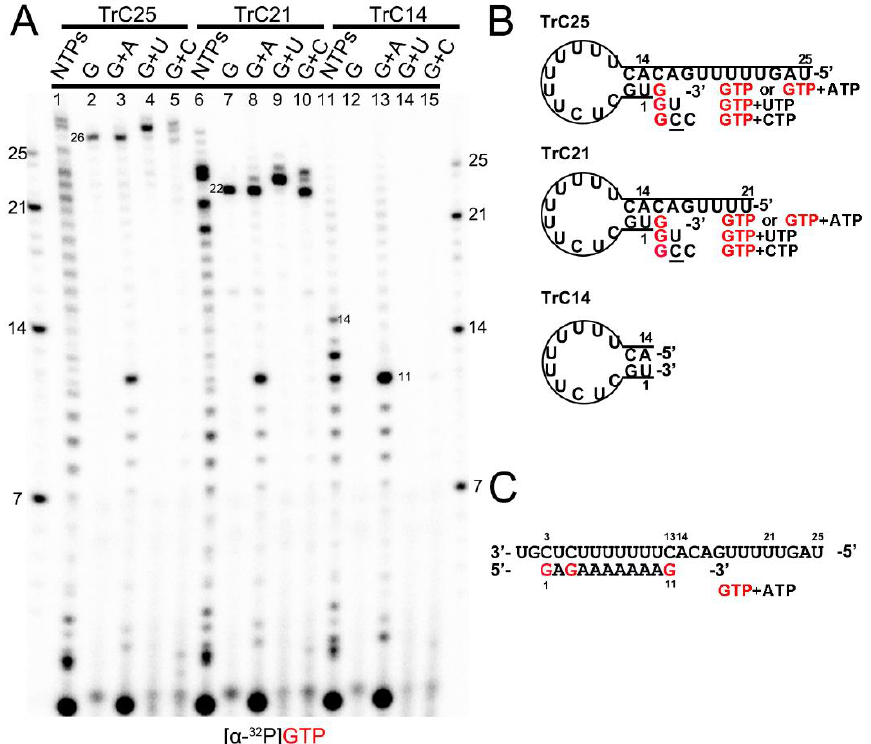
Figure 1. Back-priming-based RNA elongation with different NTPs. ( A ) The RNA synthesis of the templates TrC14, TrC21, and TrC25 in the presence of different NTPs (NTPs, GTP only, GTP+ATP, GTP+UTP, or GTP+CTP) by RSV polymerase (5 μCi of [α - 32 P] GTP was added in each reaction beside other NTPs). ( B ) The back-priming secondary structures of TrC25, TrC21, and TrC14 are predicted by mFold. The CTP in the wobble base pair A-C is underlined. ( C ) RNA synthesis starts at position 3 of the templates TrC25, TrC21, and TrC14 in the presence of GTP and ATP. Red G or GTP indicates radiolabeled GTP.